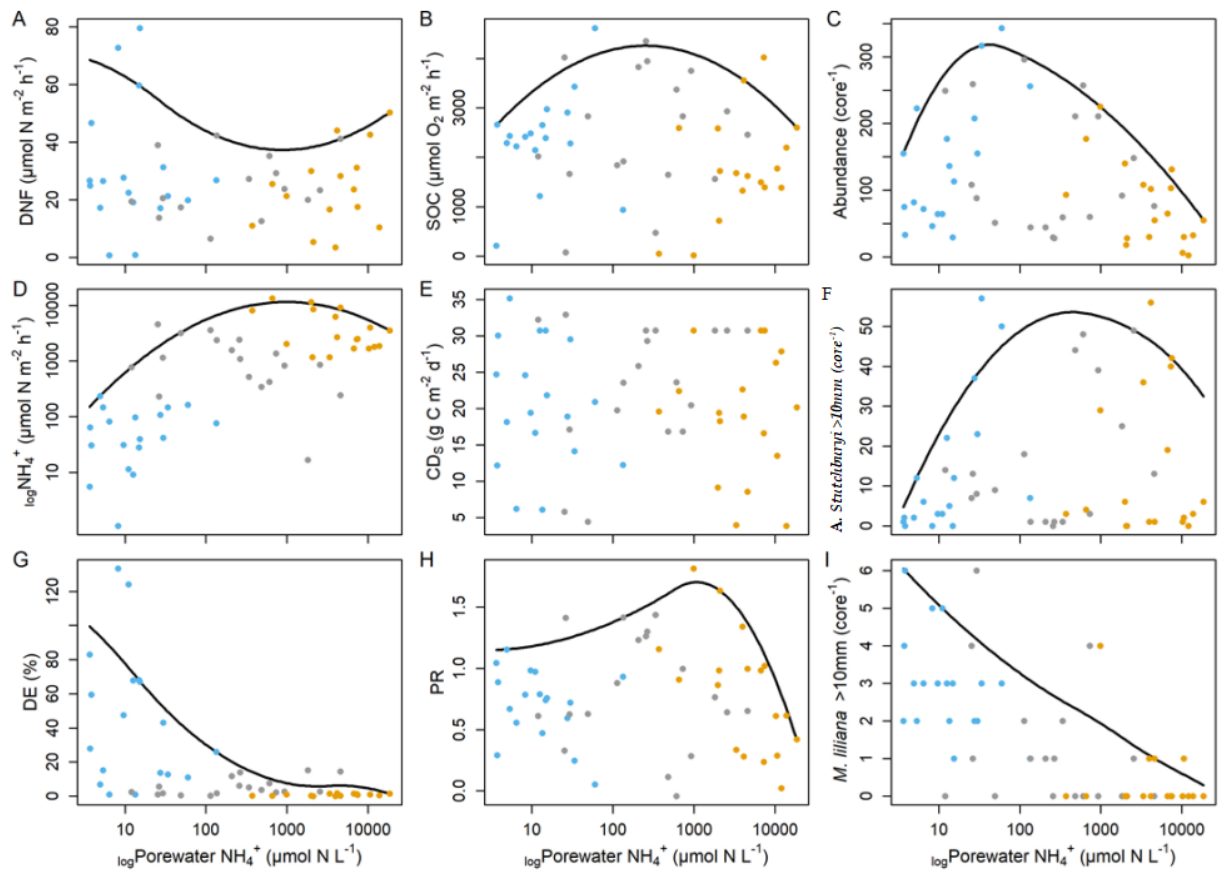
Figure 3. Bivariate scatter plots of nitrogen ( A , D , G ) and carbon ( B , E , H ) cycling parameters and univariate macrofaunal indices ( C , F , I ) showing factor-ceiling relationships (black line) at the 90th percentile. Where the line is missing, the relationship did not change with increasing enrichment. Blue, grey and orange dots are given as a reference to control, medium and high nutrient enrichment treatments, respectively. Data included are from summer only (n = 54).